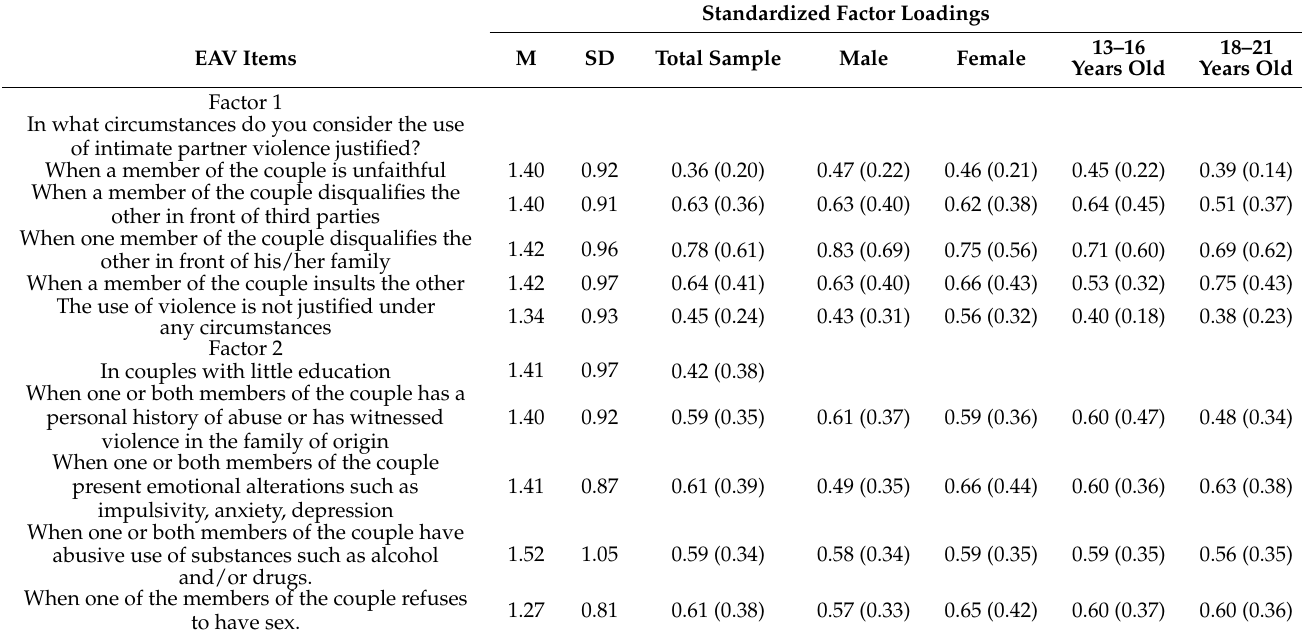
Table 2. Descriptive statistics and standardized factor loadings for the Attitudes Scale towards Violence (EAV)